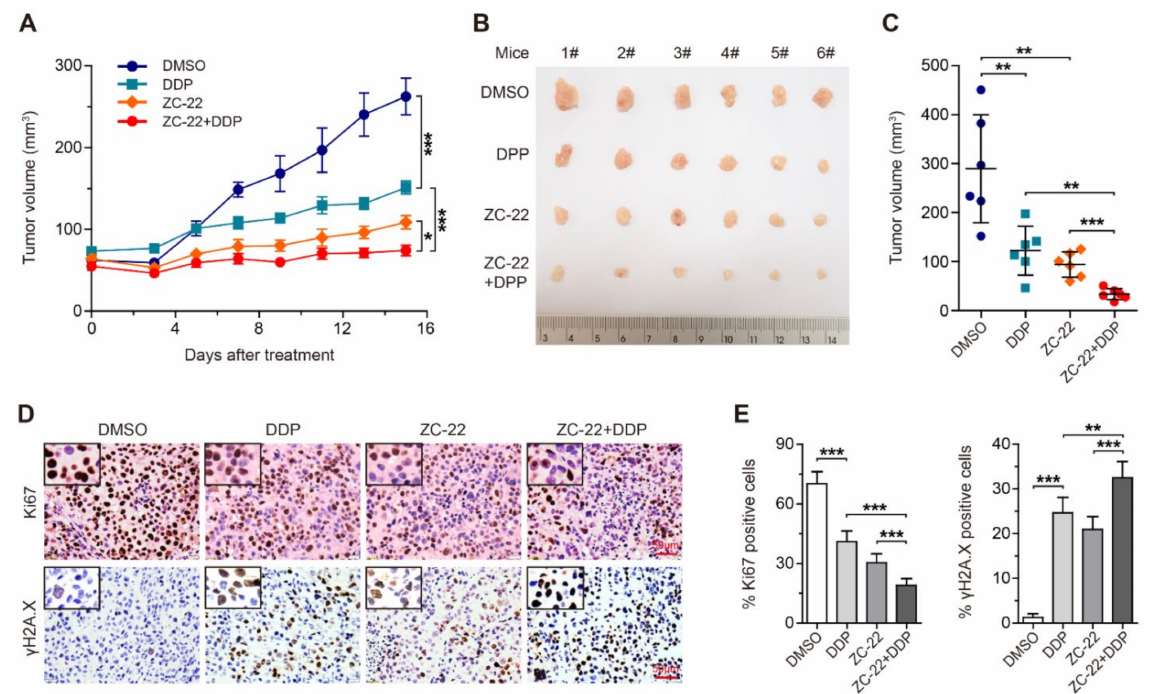
Figure 6. ZC-22 sensitizes breast cancer cells to cisplatin treatment in vivo. Female NOD-SCID mice were injected subcutaneously with 2 × 10 6 of MDA-MB-231 cells and treated ip daily with 1.5 mg/kg of cisplatin (DDP) or 50 mg/kg of ZC-22 alone or together (ZC-22 + DDP) starting on day 10 after injection of cells when tumors were 50–80 mm 3 in size. Tumor volumes were measured every 2–3 days. This experiment was simultaneously performed with that of Figure 4 and shared the same control (DMSO) group. ( A ) Growth curve of the MDA-MB-231 xenograft tumors with indicated treatment. Values are means ± SEM, n = 6. ( B , C ) Pictures ( B ) and quantification of the size ( C ) of the MDA-MB-231 xenograft tumors at the end points. Values are means ± SD, n = 6. ( D ) Immunohistochemical staining of Ki67 (top panels) and γ H2A.X (bottom panels) in the MDA- MB-231 xenograft tumor tissues. ( E ) Quantification of Ki67 (left) and γ H2A.X (right)-positive cells in immunohistochemical staining of the xenograft tumor tissues. Values are means ± SEM, n = 6. * p < 0.05, ** p < 0.01, and *** p < 0.001 in an unpaired t